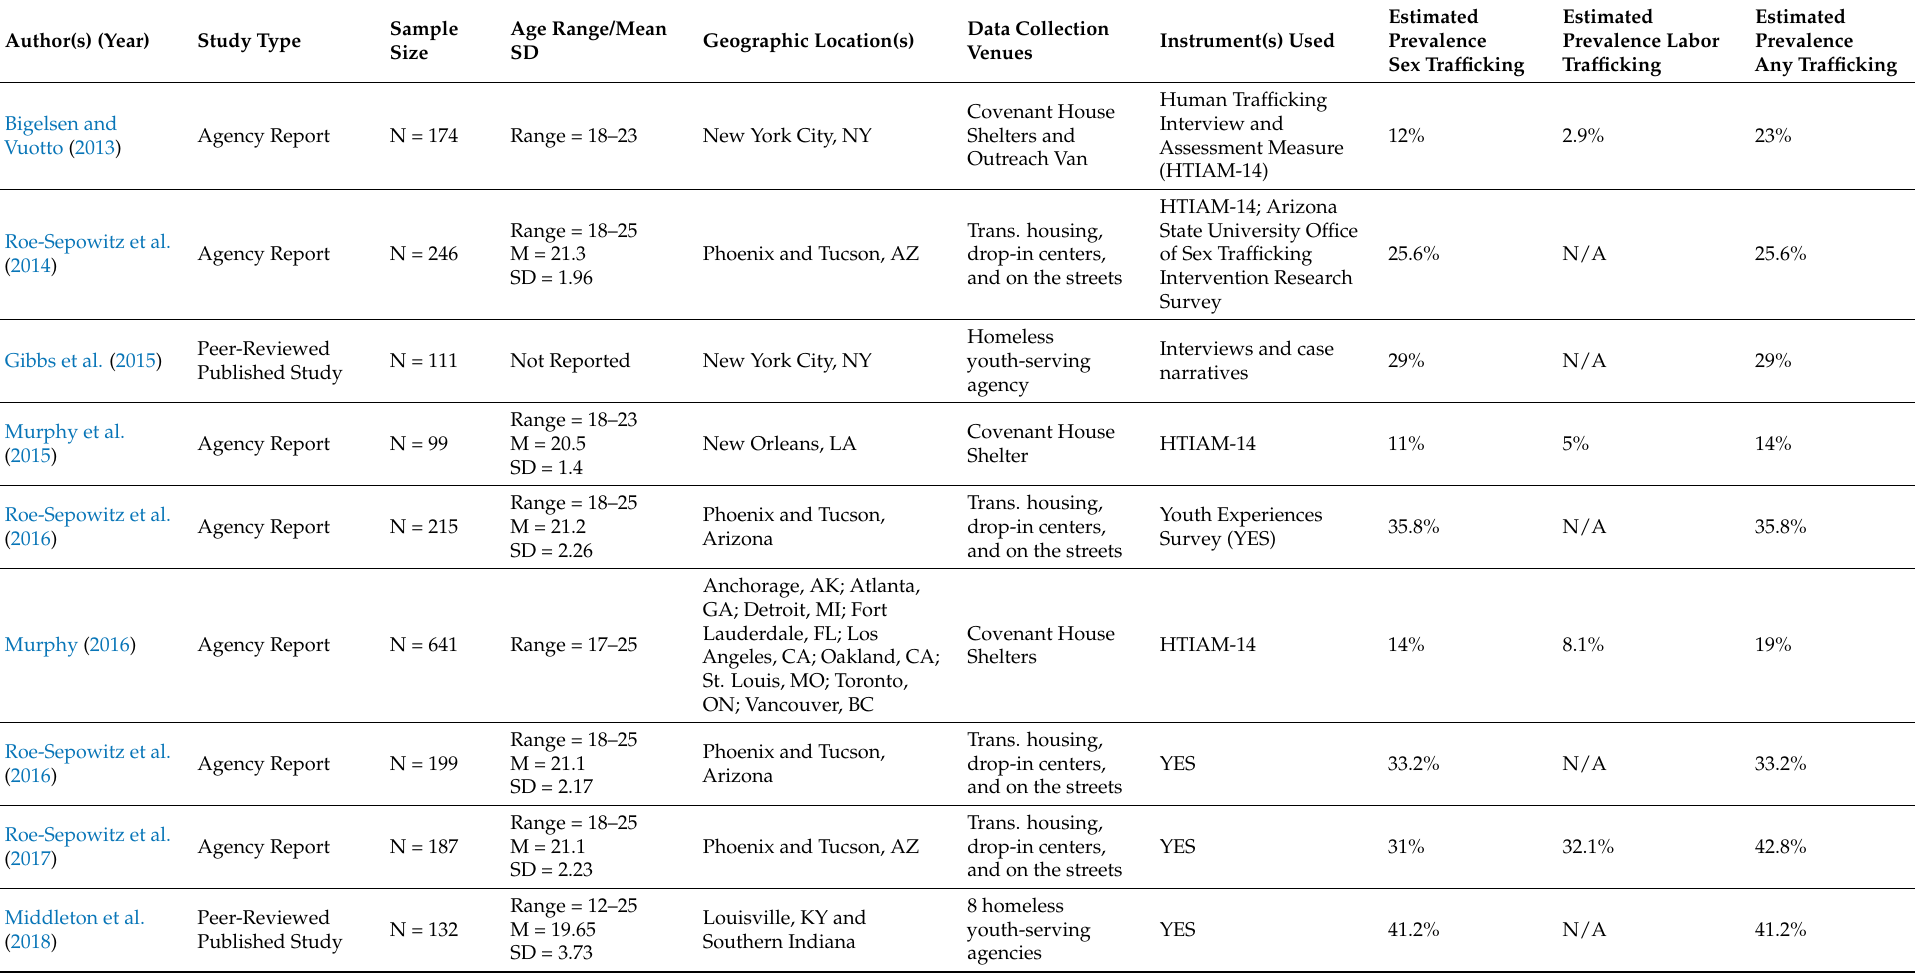
Table 1. Chronological summary of existing studies of trafficking among homeless youth,